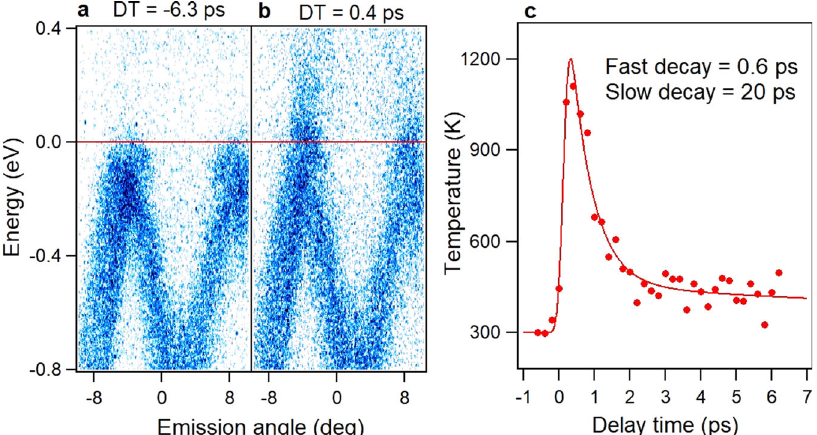
Fig. 2 Time-resolved angle-resolved photoemission spectroscopy measurements of the nodal-line bulk states. Experimental band dispersion measured along the Γ – M direction at delay times of a − 6.3 ps and b 0.4 ps. The states above the Fermi level, i.e., the non-equilibrium states can be observed only when the delay value is positive. c The transient electronic temperature as a function of the time delay (red dots) and the corresponding fi tting curve (solid line). The fi tting function is the convolution between a Gaussian pulse and a bi-exponential decay.